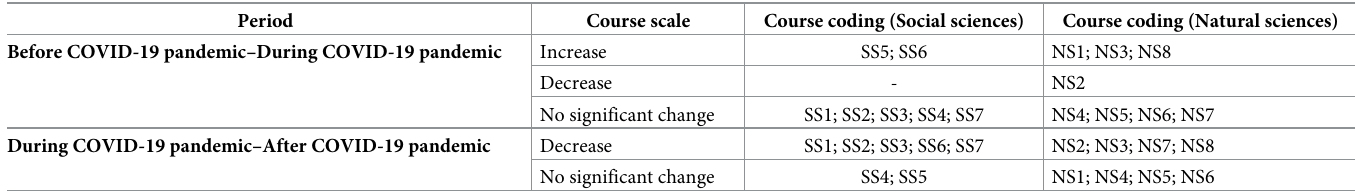
Table 5. Courses’ scale